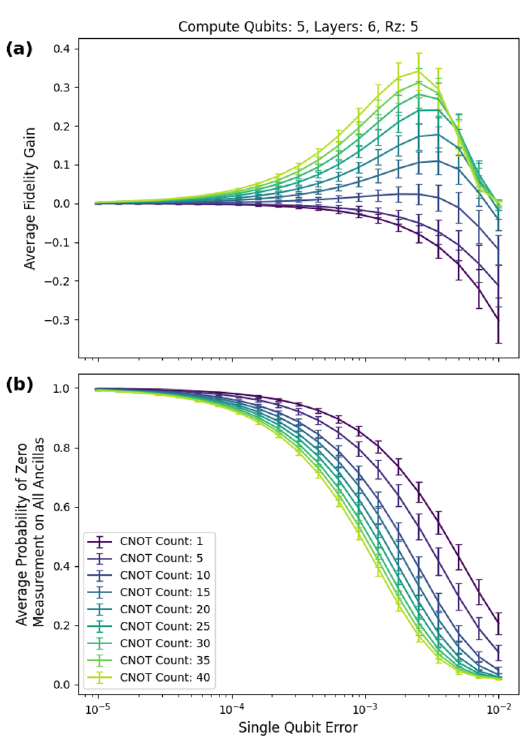
Figure 10. Six layers. ( a ) The peak average fidelity gain of 34 percentage points occurred at a single-qubit error of approximately 0.00251 (0.0251 two-qubit error) and 40 CNOTs. ( b ) The probability of postselecting decreases with increasing error rate and increasing cnot